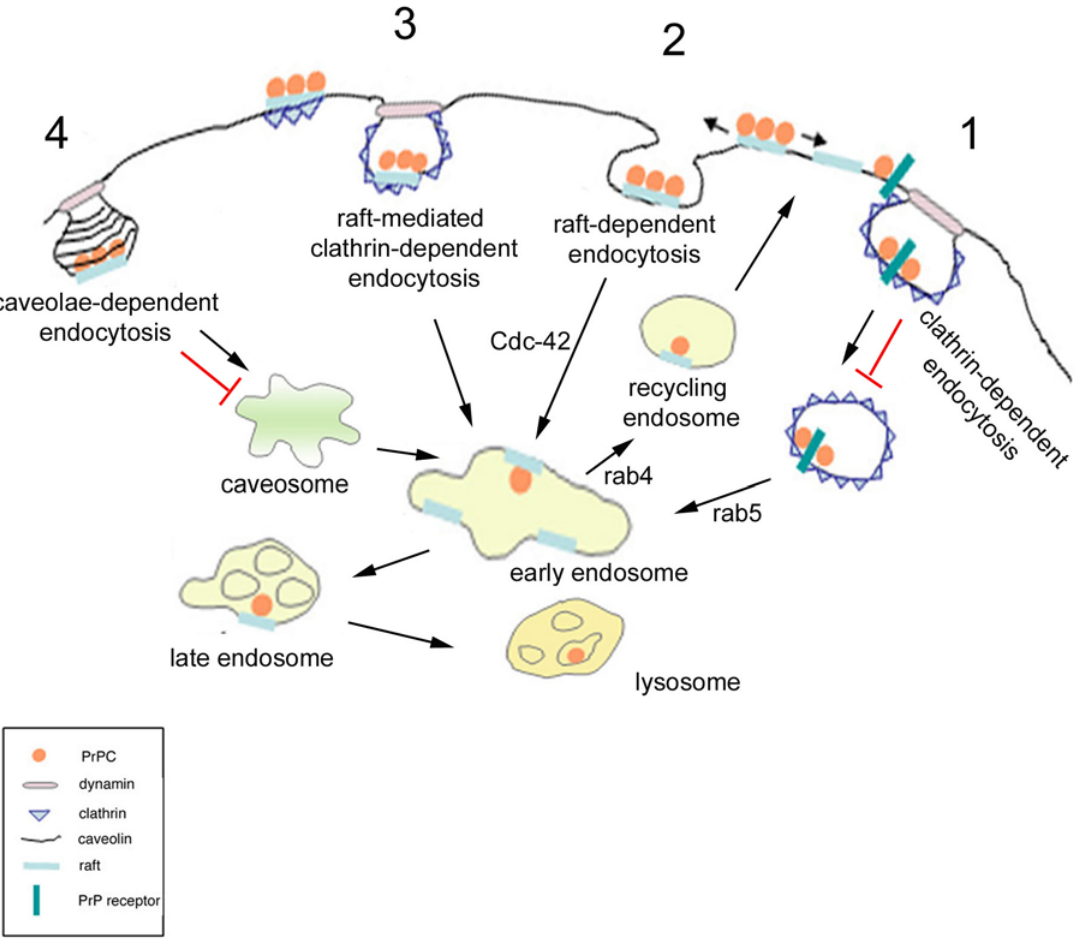
Figure 7. Mechanisms of PrP C internalization in FRT cells. Internalization of molecules can occur throughout many different pathways: the classical, clathrin-mediated pathway (1); the clathrin-independent raft-dependent pathway (2); the raft-mediated clathrin-dependent route (3) and caveolae (4). At the cell surface of FRT cells PrPC is localized in DRMs. As PrPC remains in these domains during its internalization a classical clathrin- dependent pathway (1) seems to be excluded. Conversely PrPC can undertake a rafts dependent pathway (2) and/or rafts might promote its recruitment to clathrin domains inducing its internalization (3). PrPC resides in caveolae at the plasma membrane but is not internalized via the caveolar pathway (4).